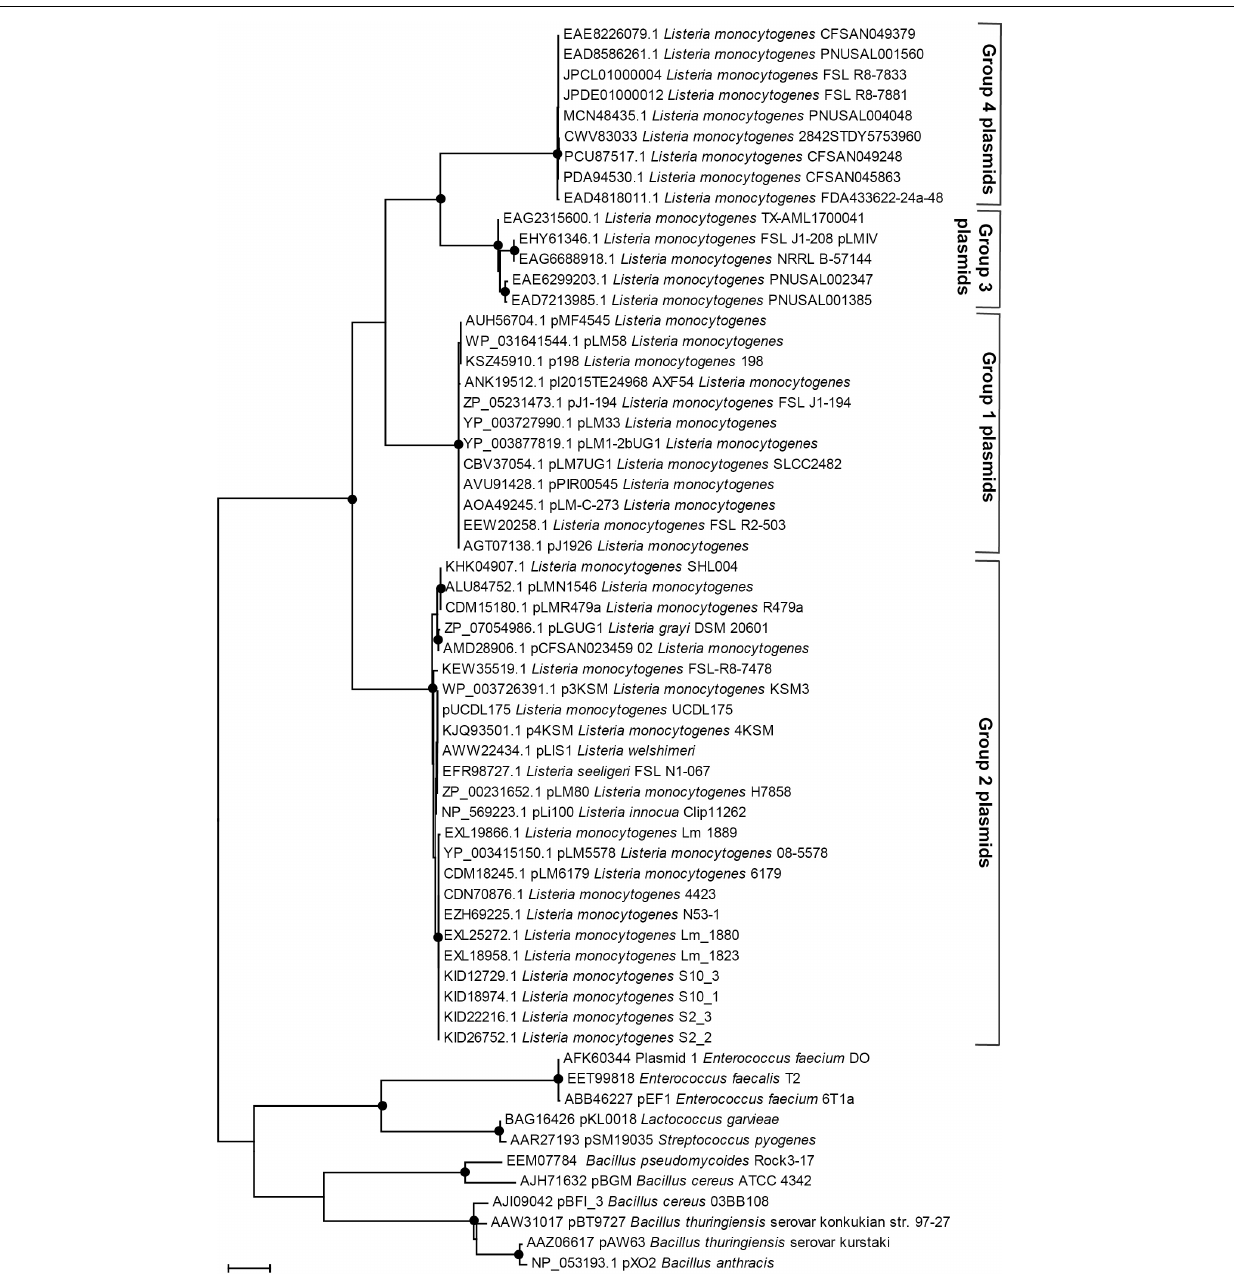
FIGURE 3 | Phylogenetic relationships of plasmid replication protein RepA amino acid sequences. The evolutionary history was inferred by using the Maximum Likelihood method based on the JTT matrix-based model. The tree with the highest log-likelihood is shown. Initial tree(s) for the heuristic search were obtained automatically by applying Neighbor-Join and BioNJ algorithms to a matrix of pairwise distances estimated using a JTT model and then selecting the topology with superior log likelihood value. The tree is drawn to scale, with branch lengths measured in the number of substitutions per site. The analysis involved 61 amino acid sequences. All positions containing gaps and missing data were eliminated. Evolutionary analyses were conducted in MEGA7 (Kumar et al., 2016). The percentage of trees in which the associated taxa clustered together based on Maximum Parsimony and Maximum Likelihood is shown as black dots; the dots represent bootstrap values > 90% using 1,000 ×